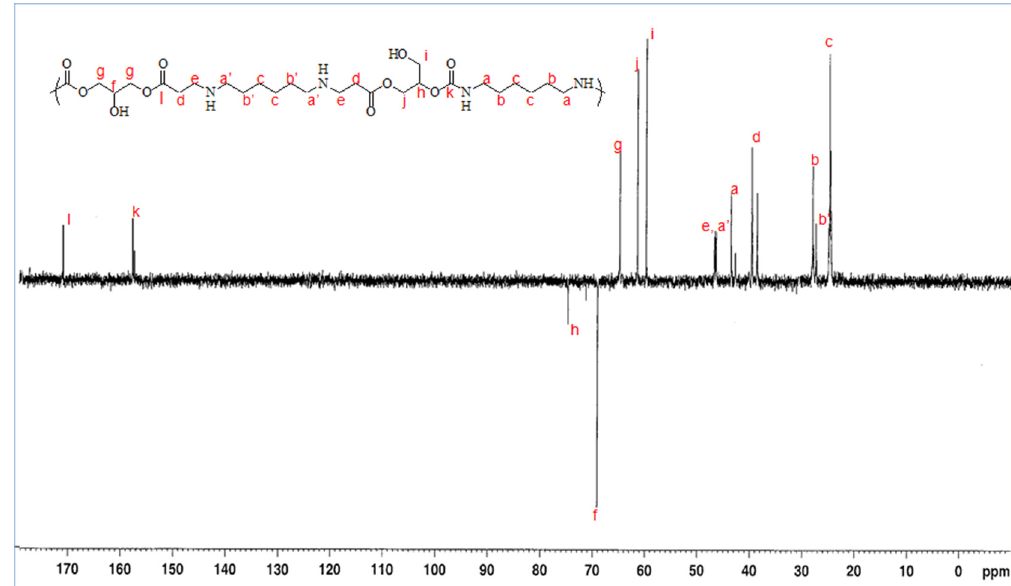
Figure 6. Representation and nomenclature for a glycerol amino ethylene ester PHUs for 13 C-NMR (dept135) in D 2 O.